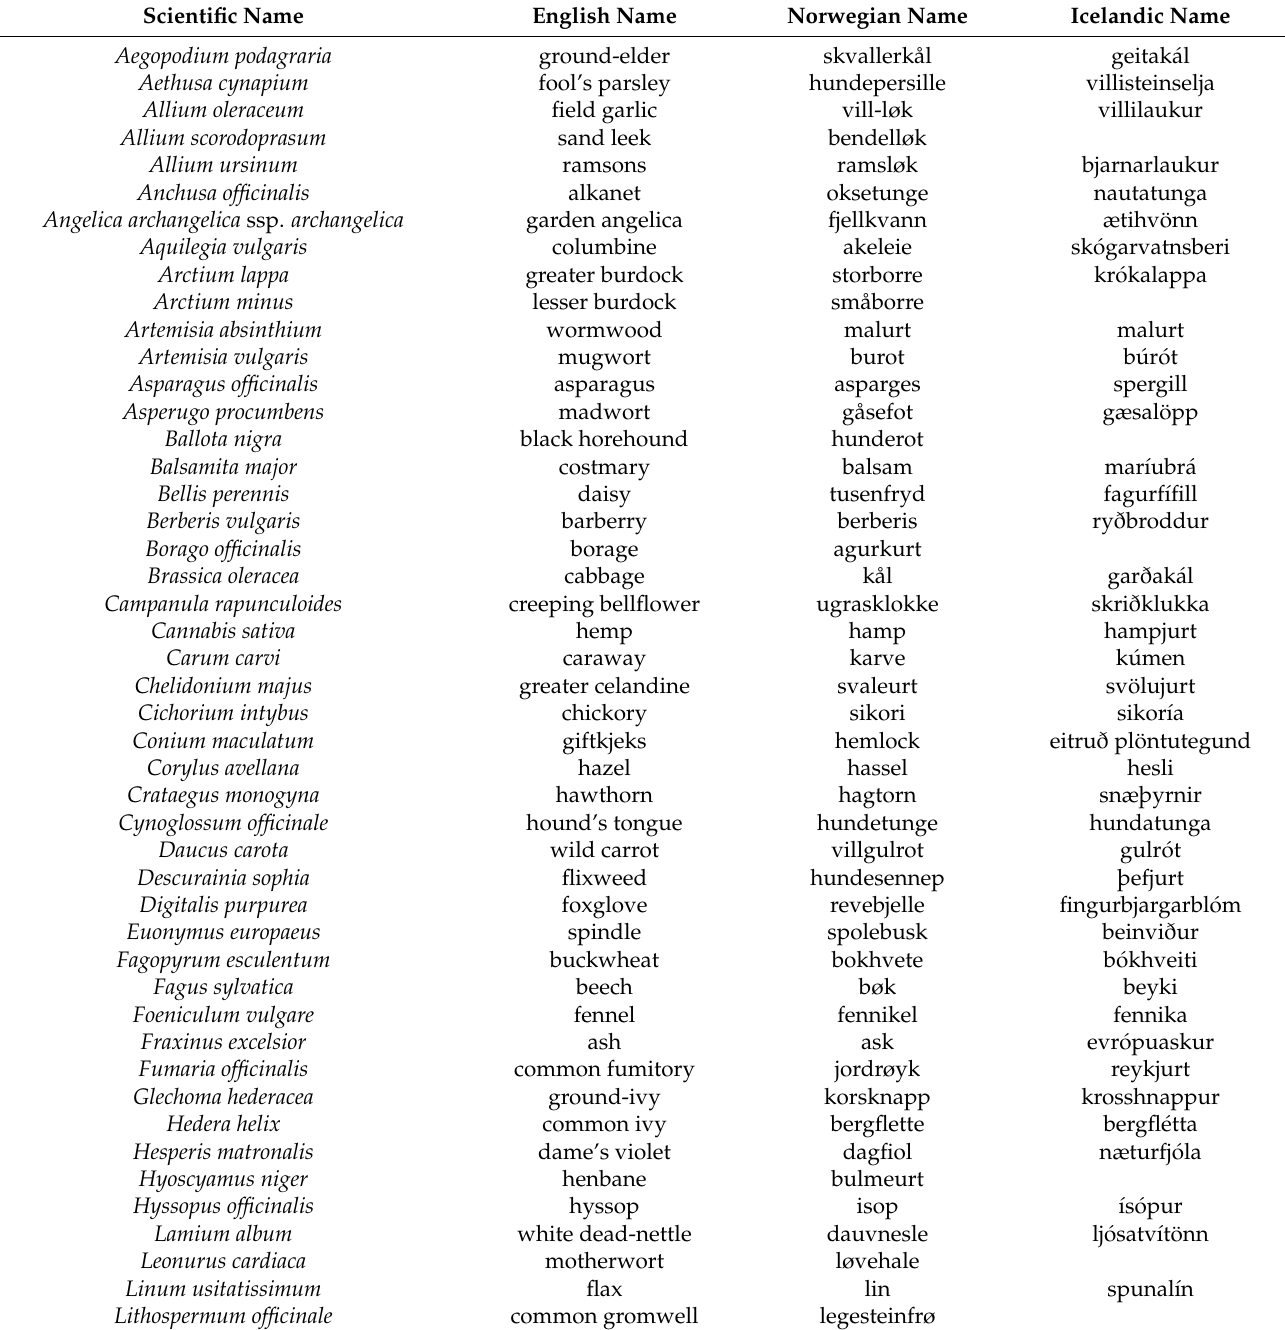
Table 1. Utility plants mentioned in the text possibly cultivated in Icelandic and Norwegian medieval monastery